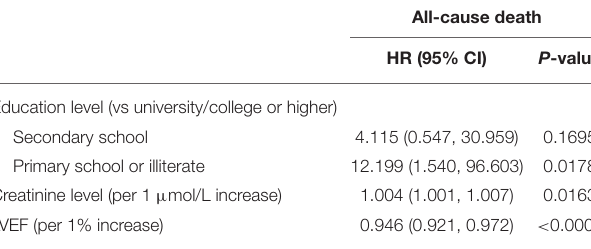
TABLE 6 | Multivariate analysis of 2-year mortality in young